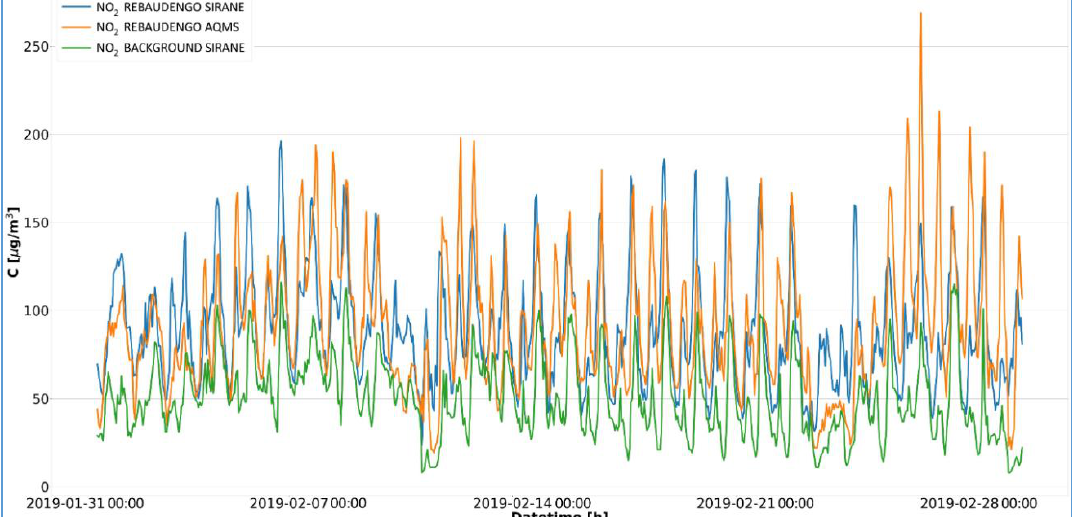
Figure 7. Time plot of NO 2 concentrations at Rebaudengo (elaboration by means of Python 3.6.5).